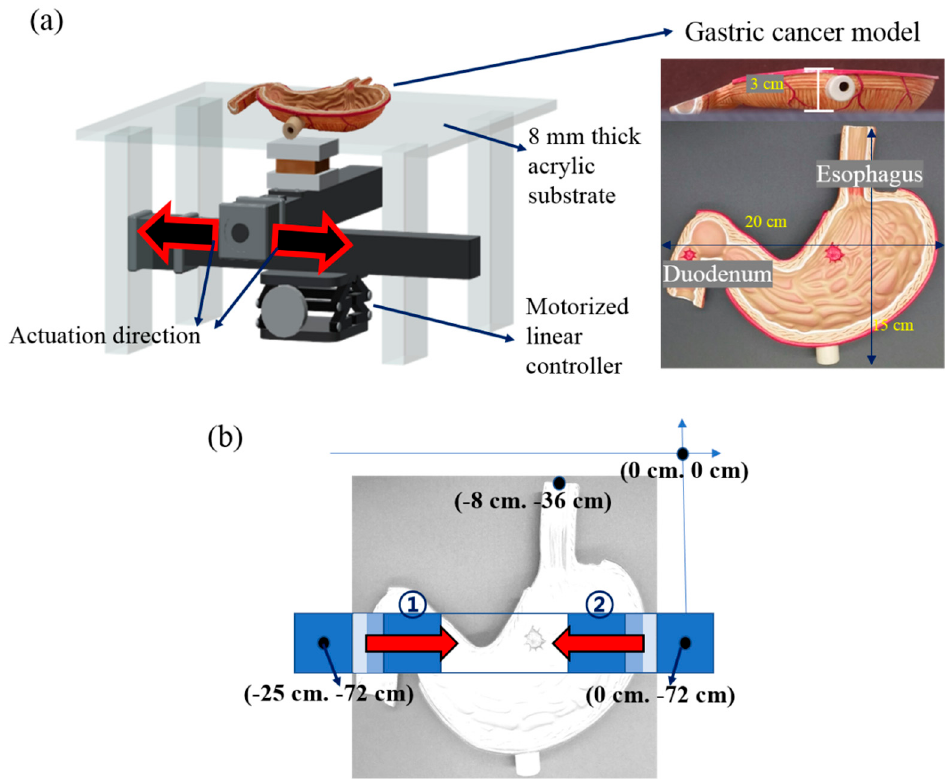
Figure 3. ( a ) Schematic of the experimental setting of the gastric cancer model; ( b ) Structural information of the stomach using the cancer model. Coordinate information for the experiment starts from the esophagus ( ① ) and duodenum ( ②